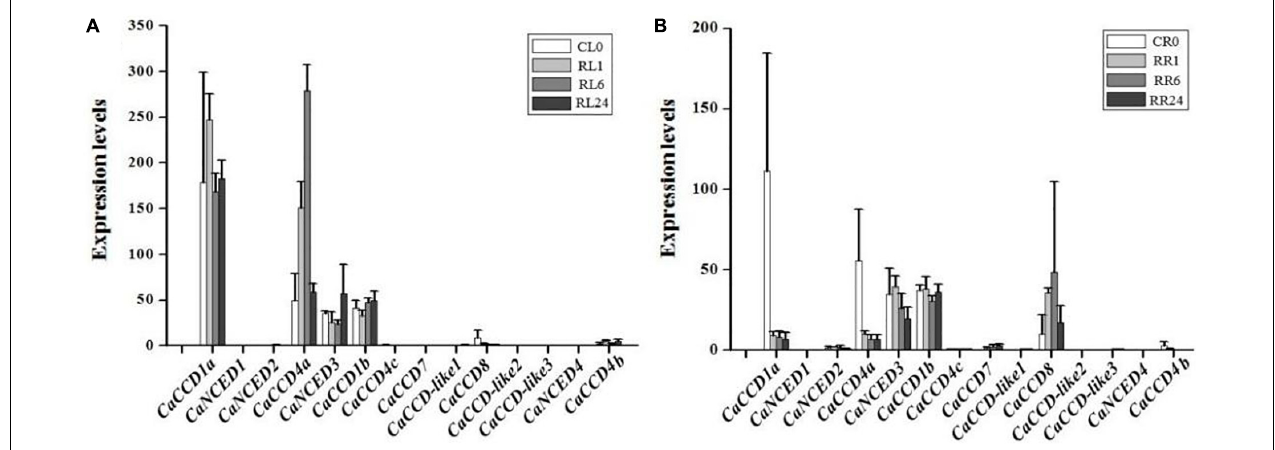
FIGURE 6 | Expression of CaCCO genes under hydrogen peroxide (H 2 O 2 ) treatment. (A) Leaves under H 2 O 2 stress and (B) roots under H 2 O 2 stress.